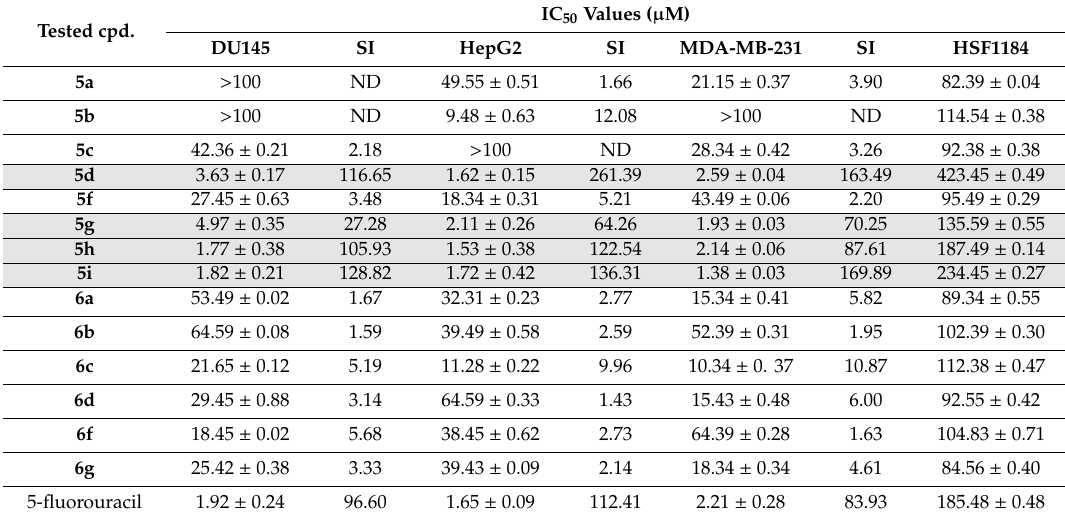
Table 1. Cytotoxic activities and selectivity indexes (SIs) of 2-methoxypyridine derivatives. Tested